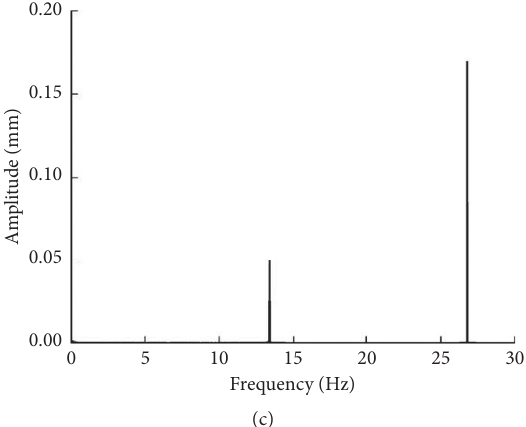
Figure 26: Period-2 motion of the system is obtained for the external excitation frequency Ω � 26 . 8 Hz: (a) waveform; (b) phase portrait; (c) amplitude spectrum.